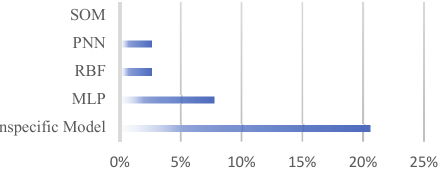
Fig. 5. Comparison of the Artificial Neural Network models